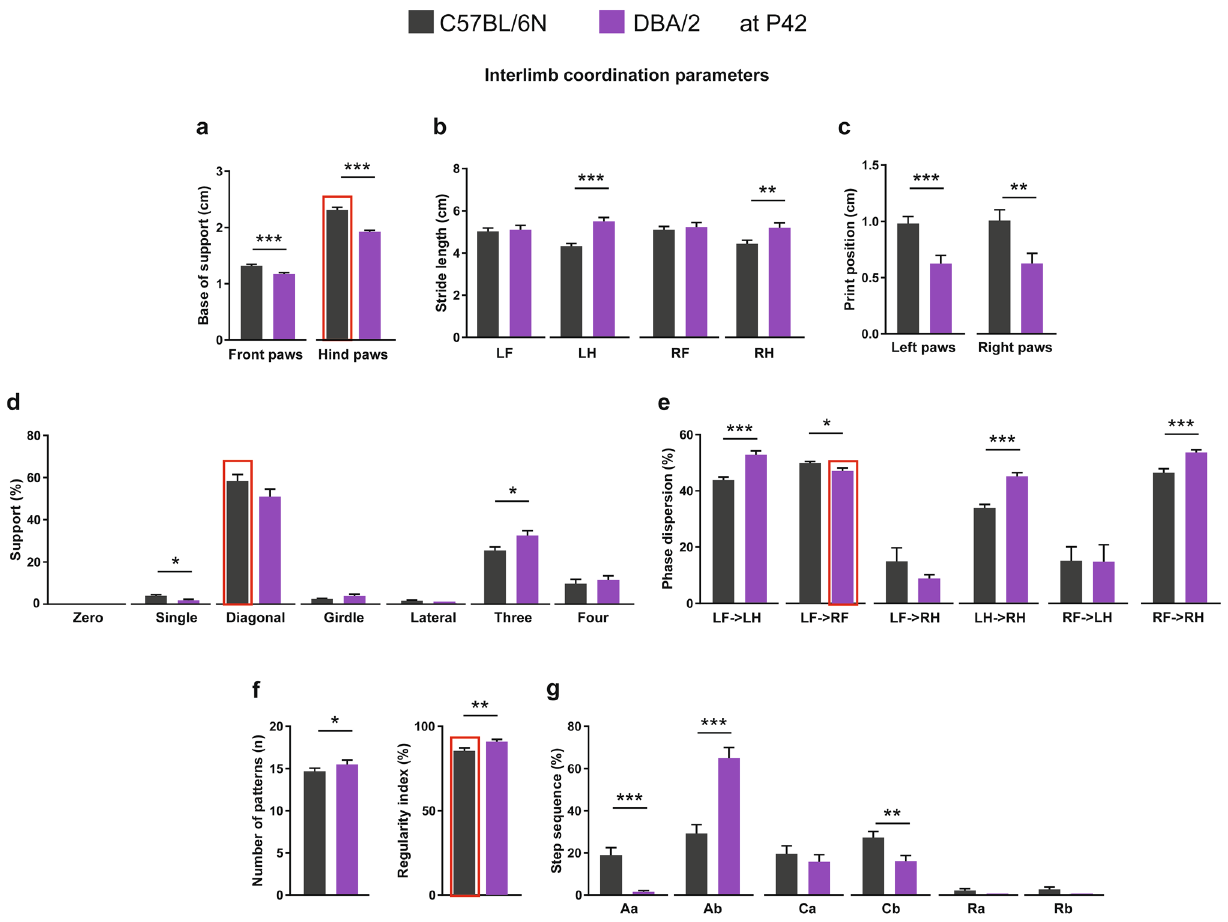
Figure 5. Comparison of interlimb coordination parameters between C57BL/6N and DBA/2 mice at P42. ( a ) DBA/2 mice showed a decrease in the base of support of both front and hind paws compared to C57BL/6N mice. ( b ) The stride lengths of both LH and RH paws were higher in DBA/2 than C57BL/6N mice. ( c ) The print positions of both left and right paws were lower in DBA/2 compared to C57BL/6N mice. ( d ) DBA/2 mice used less single but more three-paws support compared to C57BL/6N mice. ( e ) The phase dispersion percentages of LF- > LH, LH- > RH and RF- > RH were higher in DBA/2 than C57BL6N mice. ( f ) The number of patterns and regularity index were higher in DBA/2 than C57BL/6N mice. ( g ) DBA/2 mice showed lower step sequence percentages of Aa and Cb and a higher percentage of Ab compared to C57BL/6N mice. Two-way ANOVA followed by Bonferroni post hoc test, * p ≤ 0.05, ** p ≤ 0.01, *** p ≤ 0.001. A red rectangle indicates a significant difference between sexes within a strain (see Supplementary Table S1). Error bars indicate the standard error of the mean (SEM). RF right front, LF left front, RH right hind, LH left